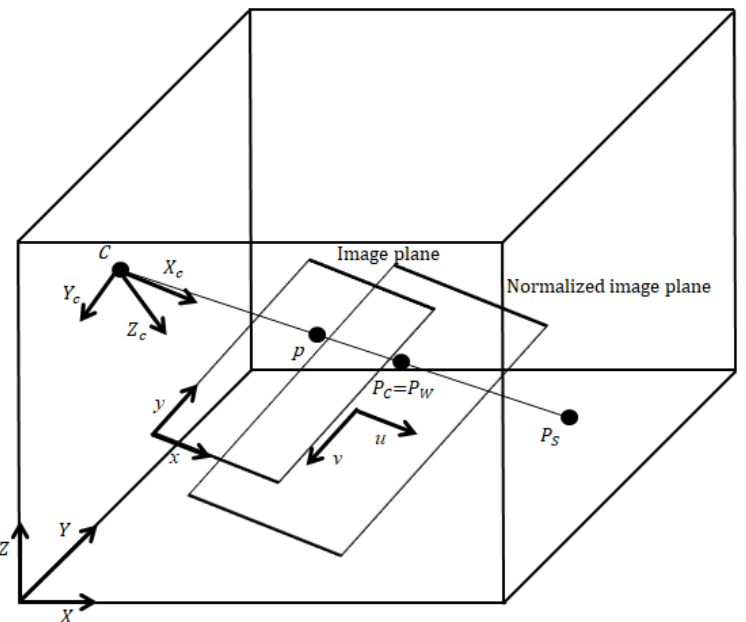
Figure 3. Relationship between world, camera, image plane, and normalized image plane coordi- nate